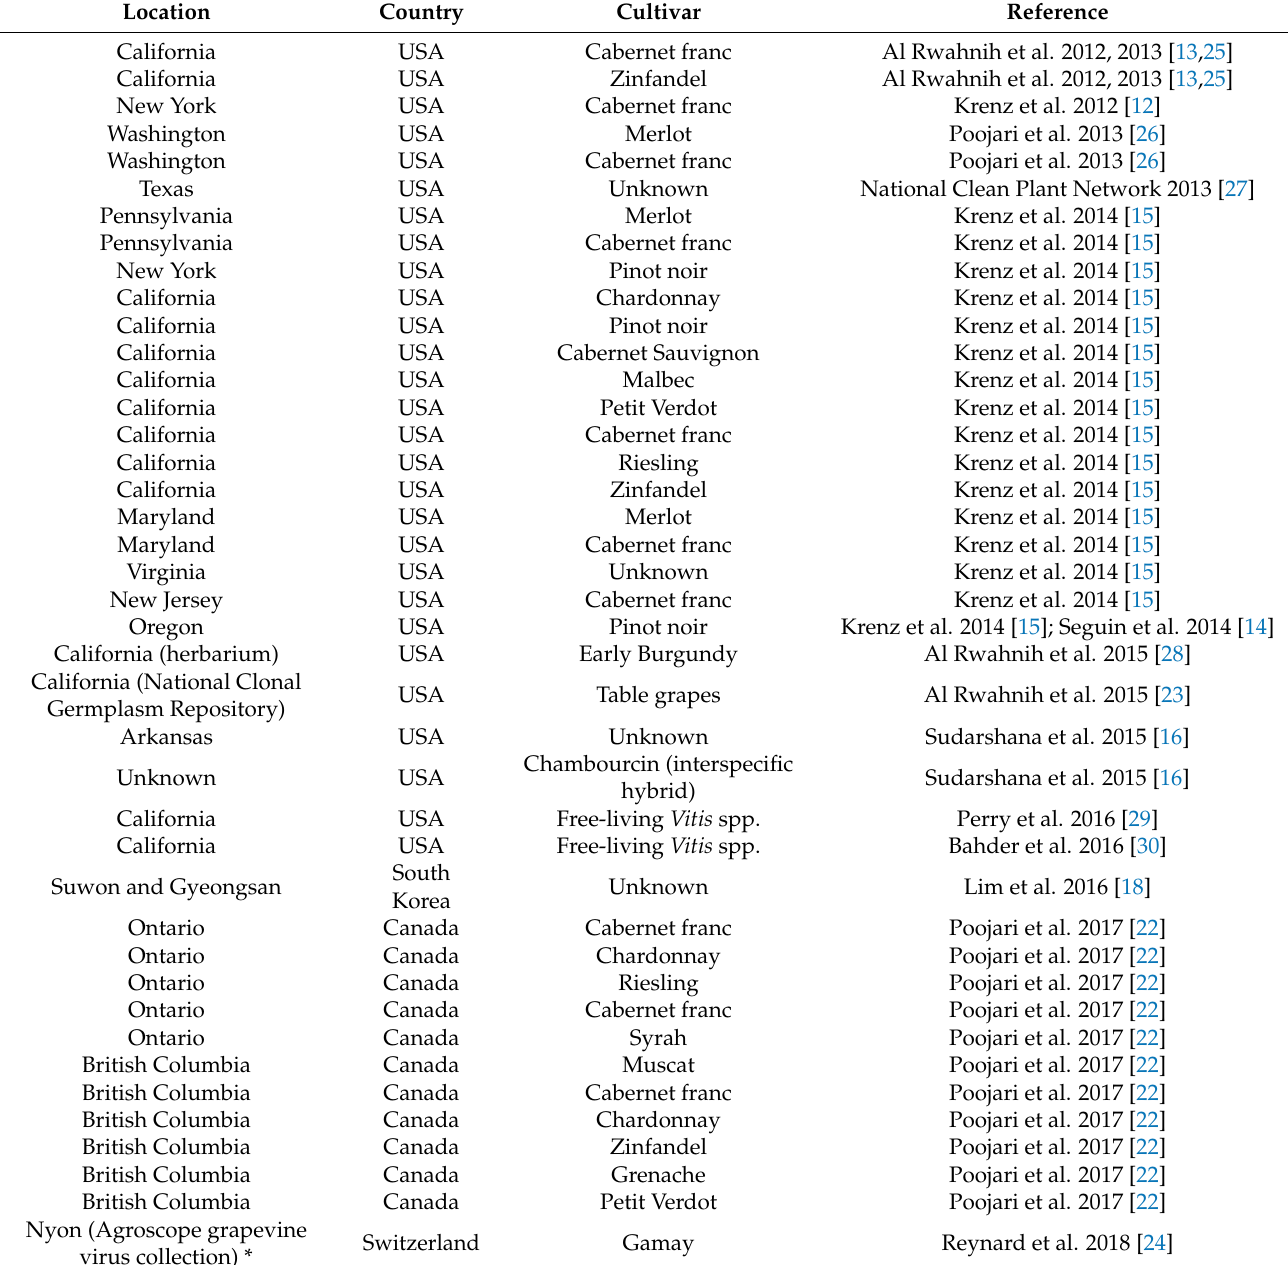
Table 1. Distribution of GBRV in the US and around the world with the cultivar(s) and date reported.